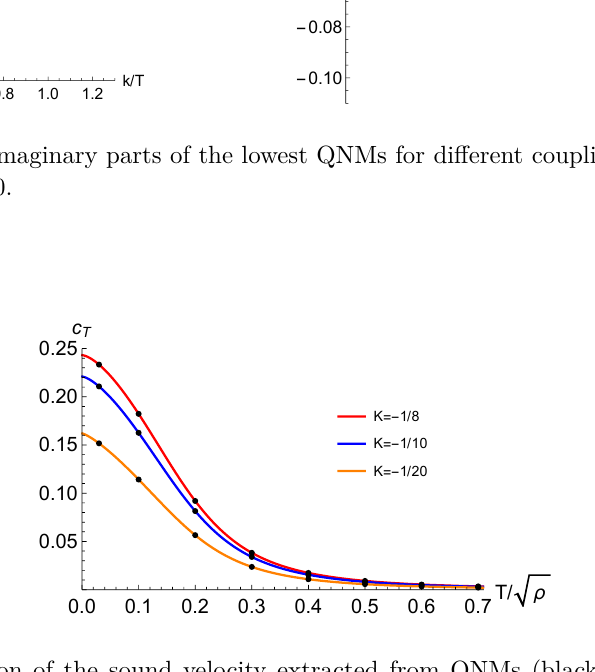
Figure 4 . Comparison of the sound velocity extracted from QNMs (black dots) and the result from the elasticity formula (3.2) (solid lines) for various values of K